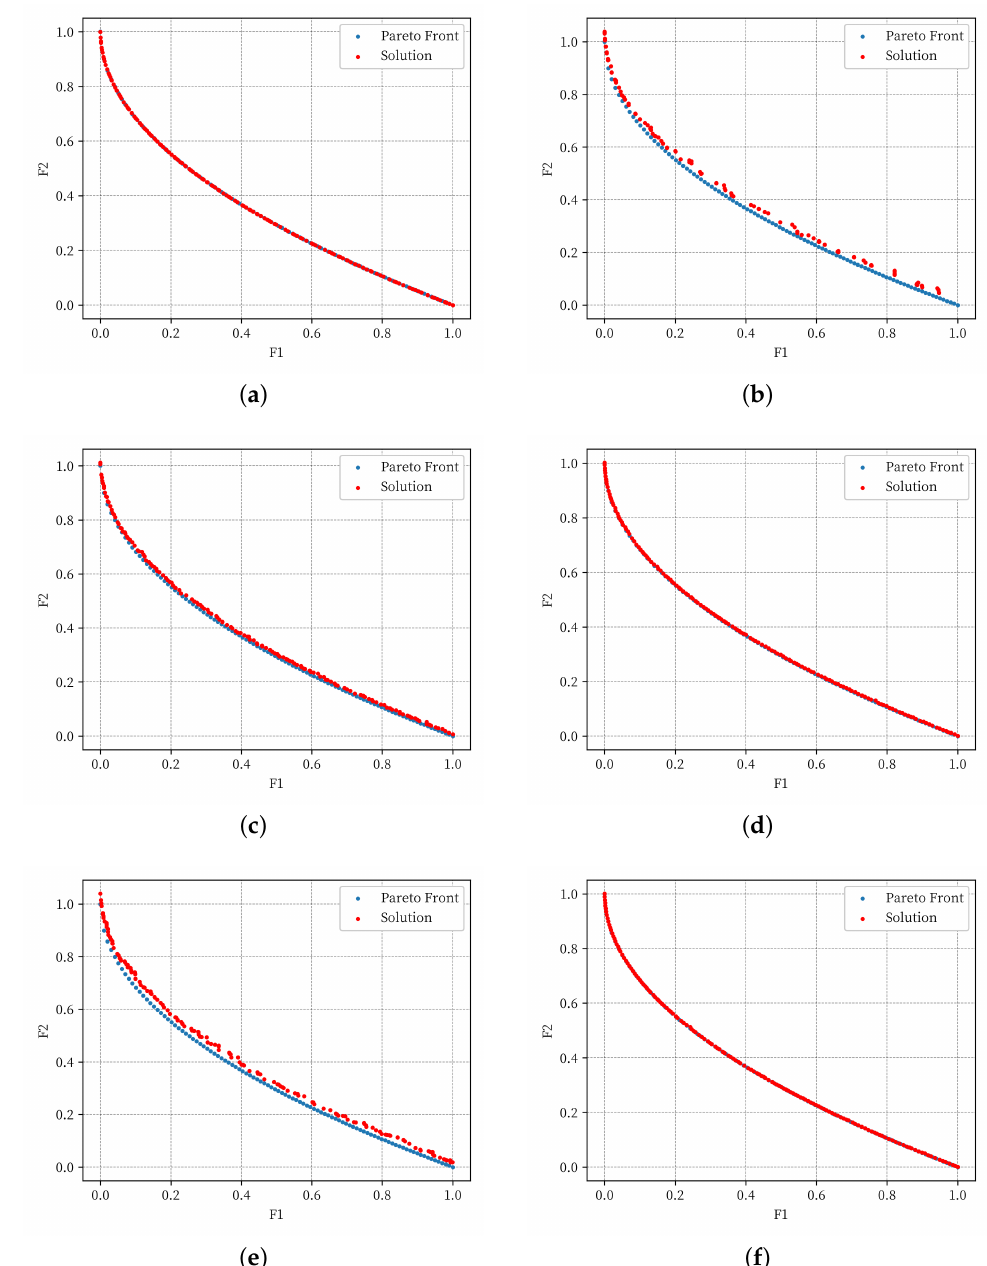
Figure 3. Comparison Between the Pareto Front and the Final Population Solution Set Obtained by the Six Different Algorithms on ZDT1 Test Problem Set. Subfigures ( a ) AGEMOEA, ( b ) MOEA/D-URAW, ( c ) NSGA-II-SDR, ( d ) CMOPSO, ( e ) MOEA/D-DAE, and ( f ) MOEA/D-DPAW correspond to the running results of algorithms AGEMOEA, MOEA/D-URAW, NSGA-II-SDR, CMOPSO, MOEA/D- DAE, and MOEA/D-DPAW,